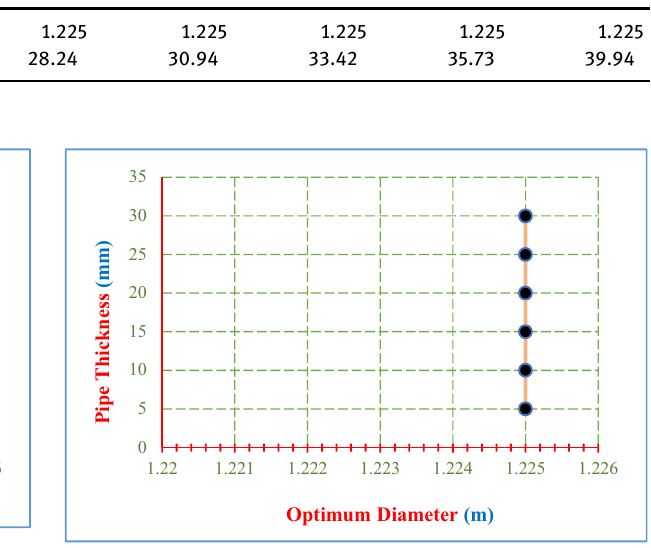
Figure 13: Steel stress vs optimum diameter.